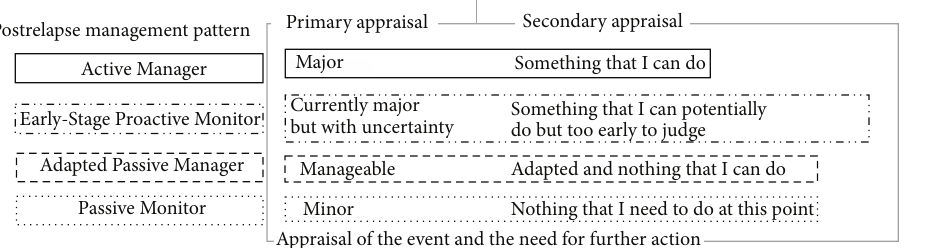
Figure 1: Relapse experience and management appraisal schematization (based on Lazarus and Folkman’s transactional model of stress, coping, and